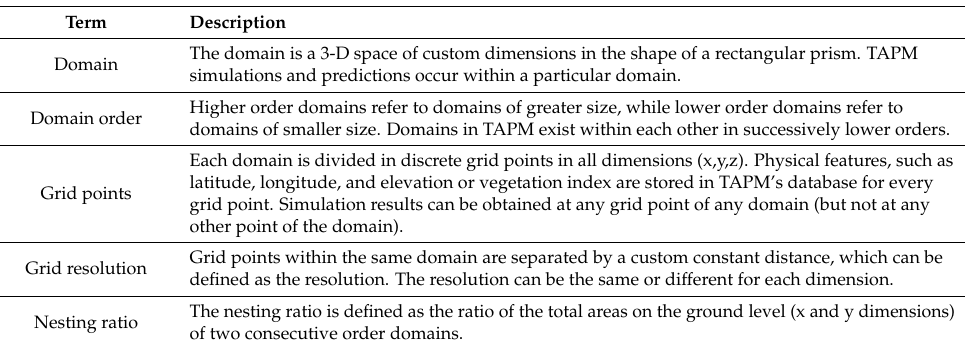
Table 1. Terminology used in reference to TAPM